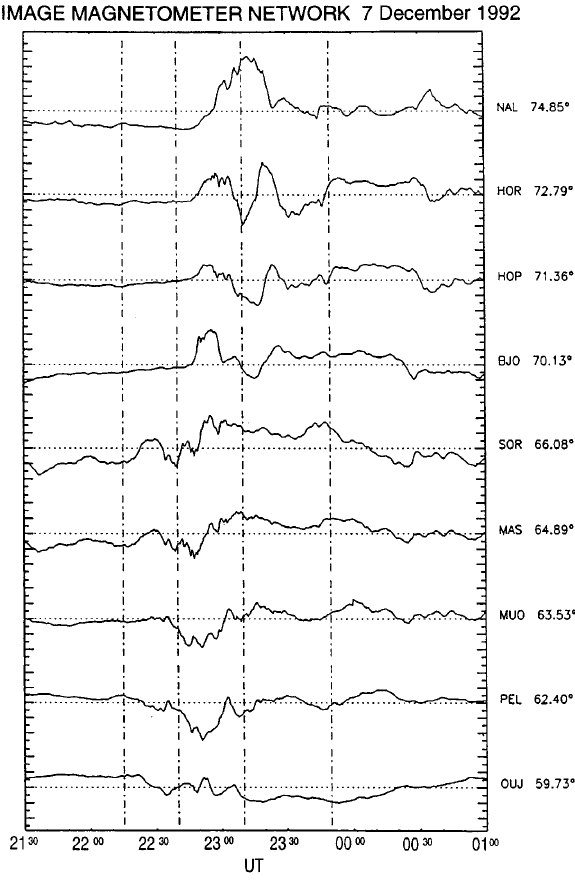
indicate the key substorm timings in this study, 2215 UT was substorm onset; 2240 UT the intensification; 2310 UT corresponds to the time when the ‘‘double oval’’ was well established; and 2350 UT was